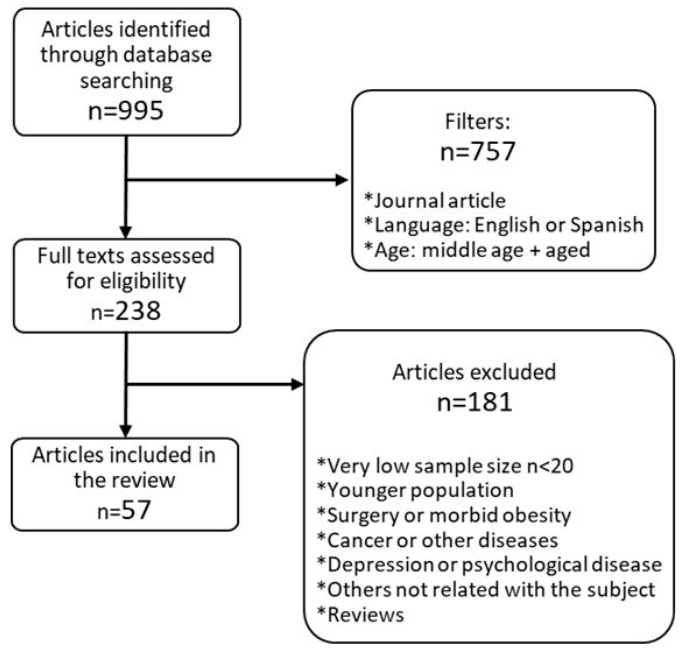
Figure 1. Flow-chart of study selection, inclusion and exclusion of studies.